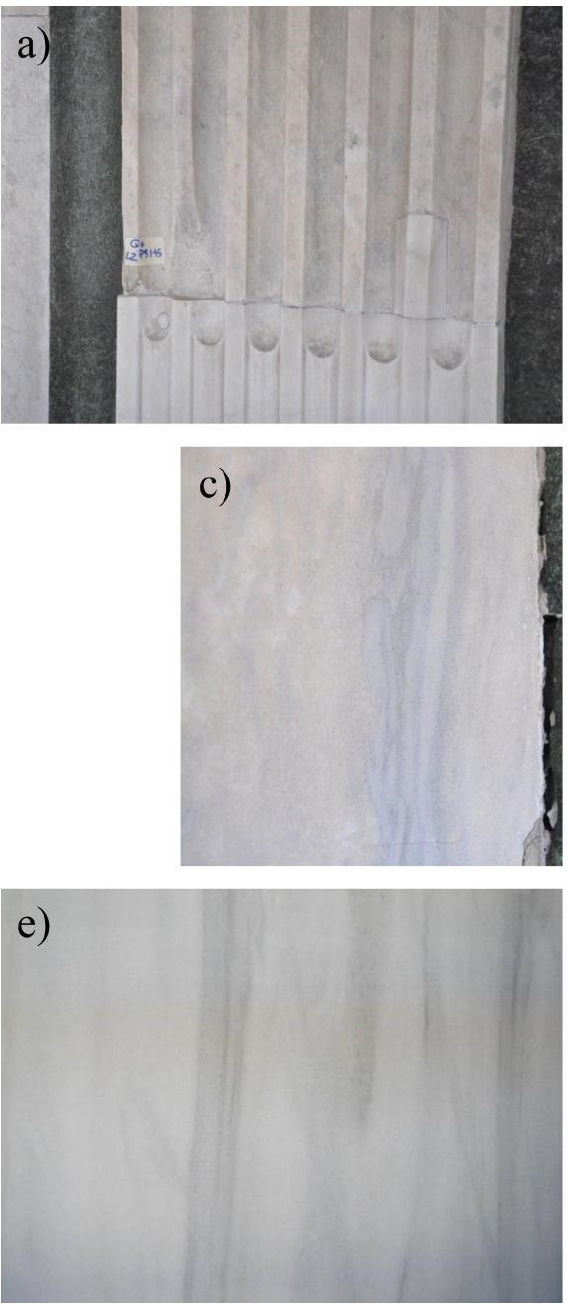
Figure 8. Macroscopic appearance and microphotograph of thin sections of marbles (by polarized optical microscopy; crossed nicols) of external cladding of the Baptistery ( a,b ) Cararra; ( c,d ) Hymettus; ( e,f ) Lasa.